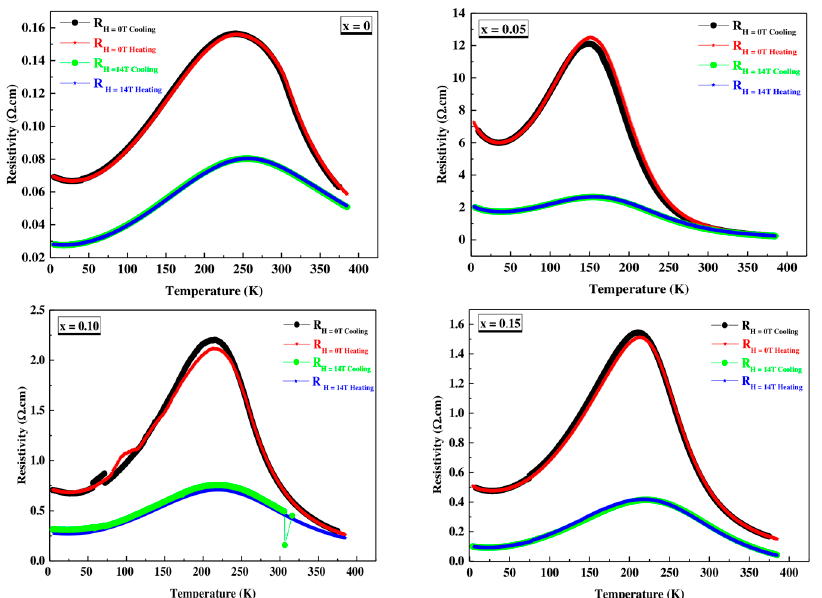
Figure 10. Temperature dependence of the resistivity ρ (T,H) without and with applied magnetic field for Pr 0.7 Sr 0.3 Mn ( 1 − x ) Co x O 3 with x = 0, 0.05, 0.10 and 0.15.